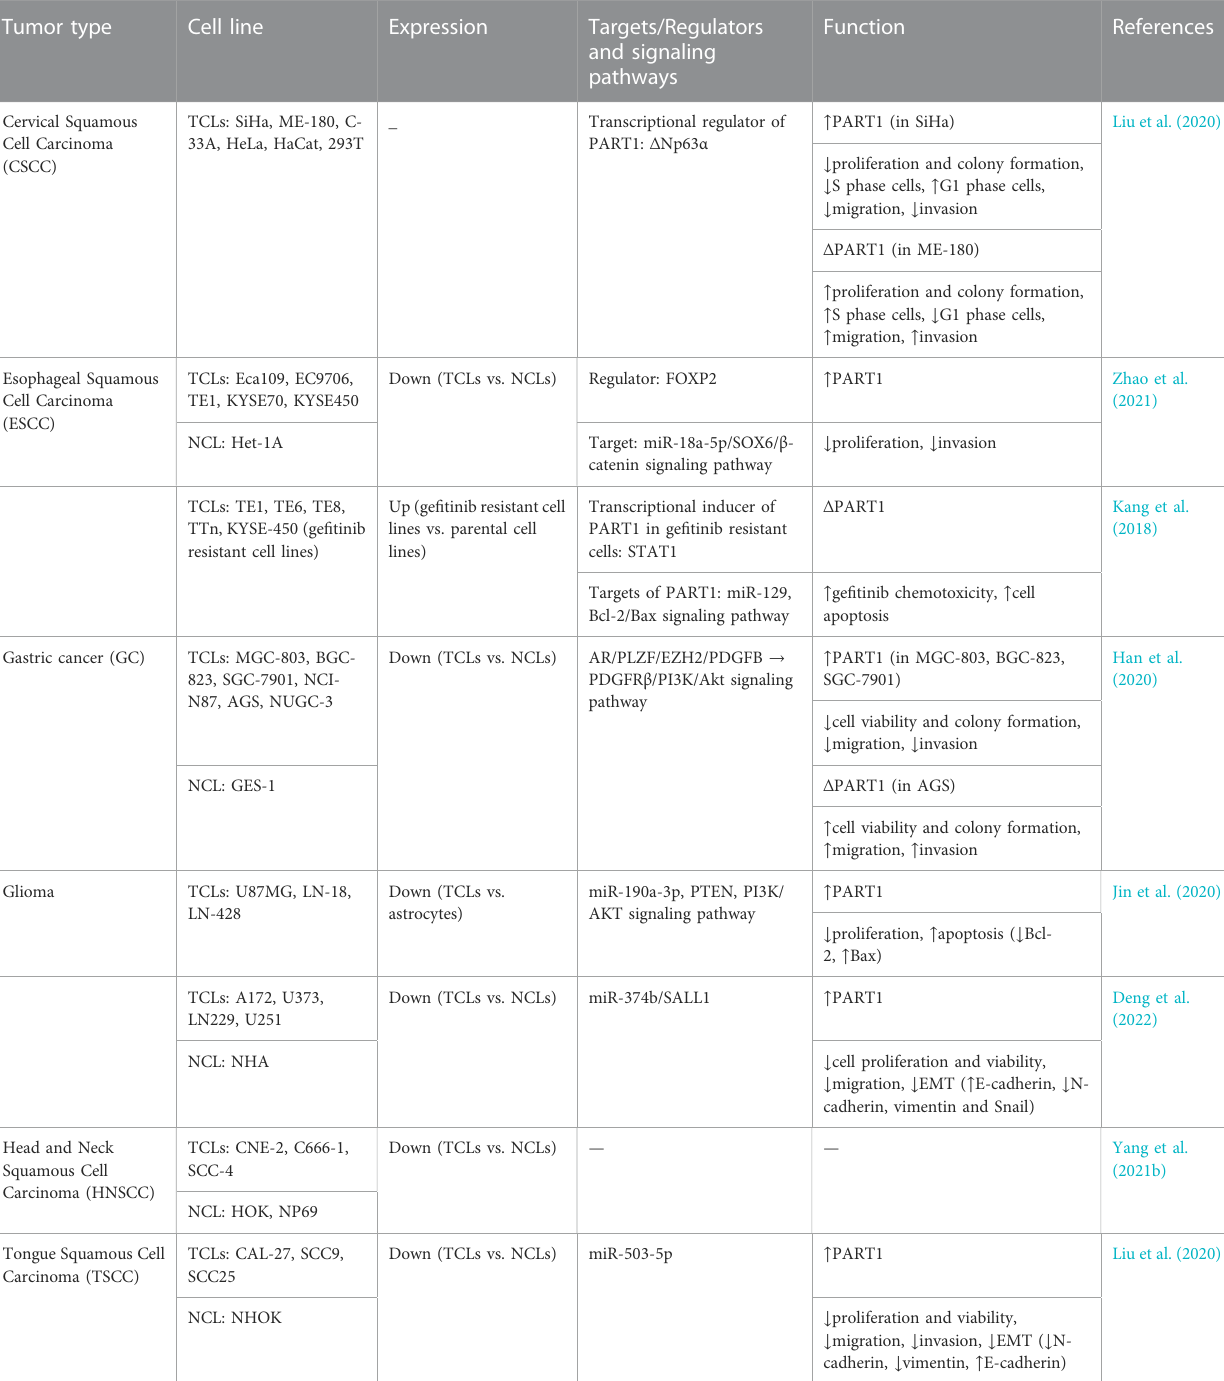
TABLE 2 In vitro experiments to examine expression and function of PART1 in malignancies in which PART1 has been down-regulated ( ↑ : increase, ↓ :